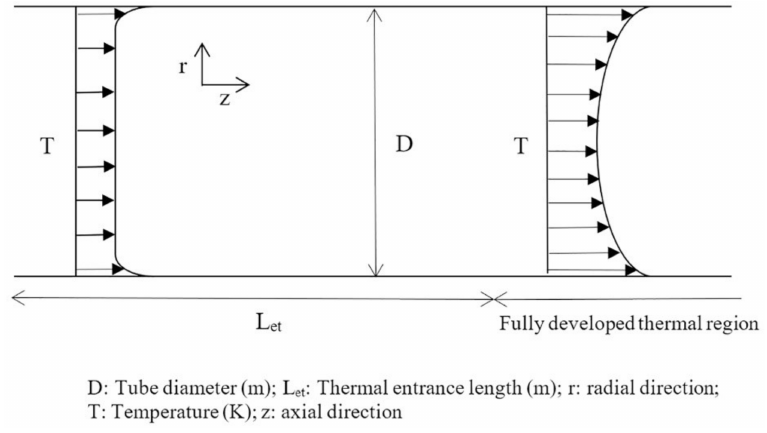
Figure 6. Temperature profile development in forced convection in a